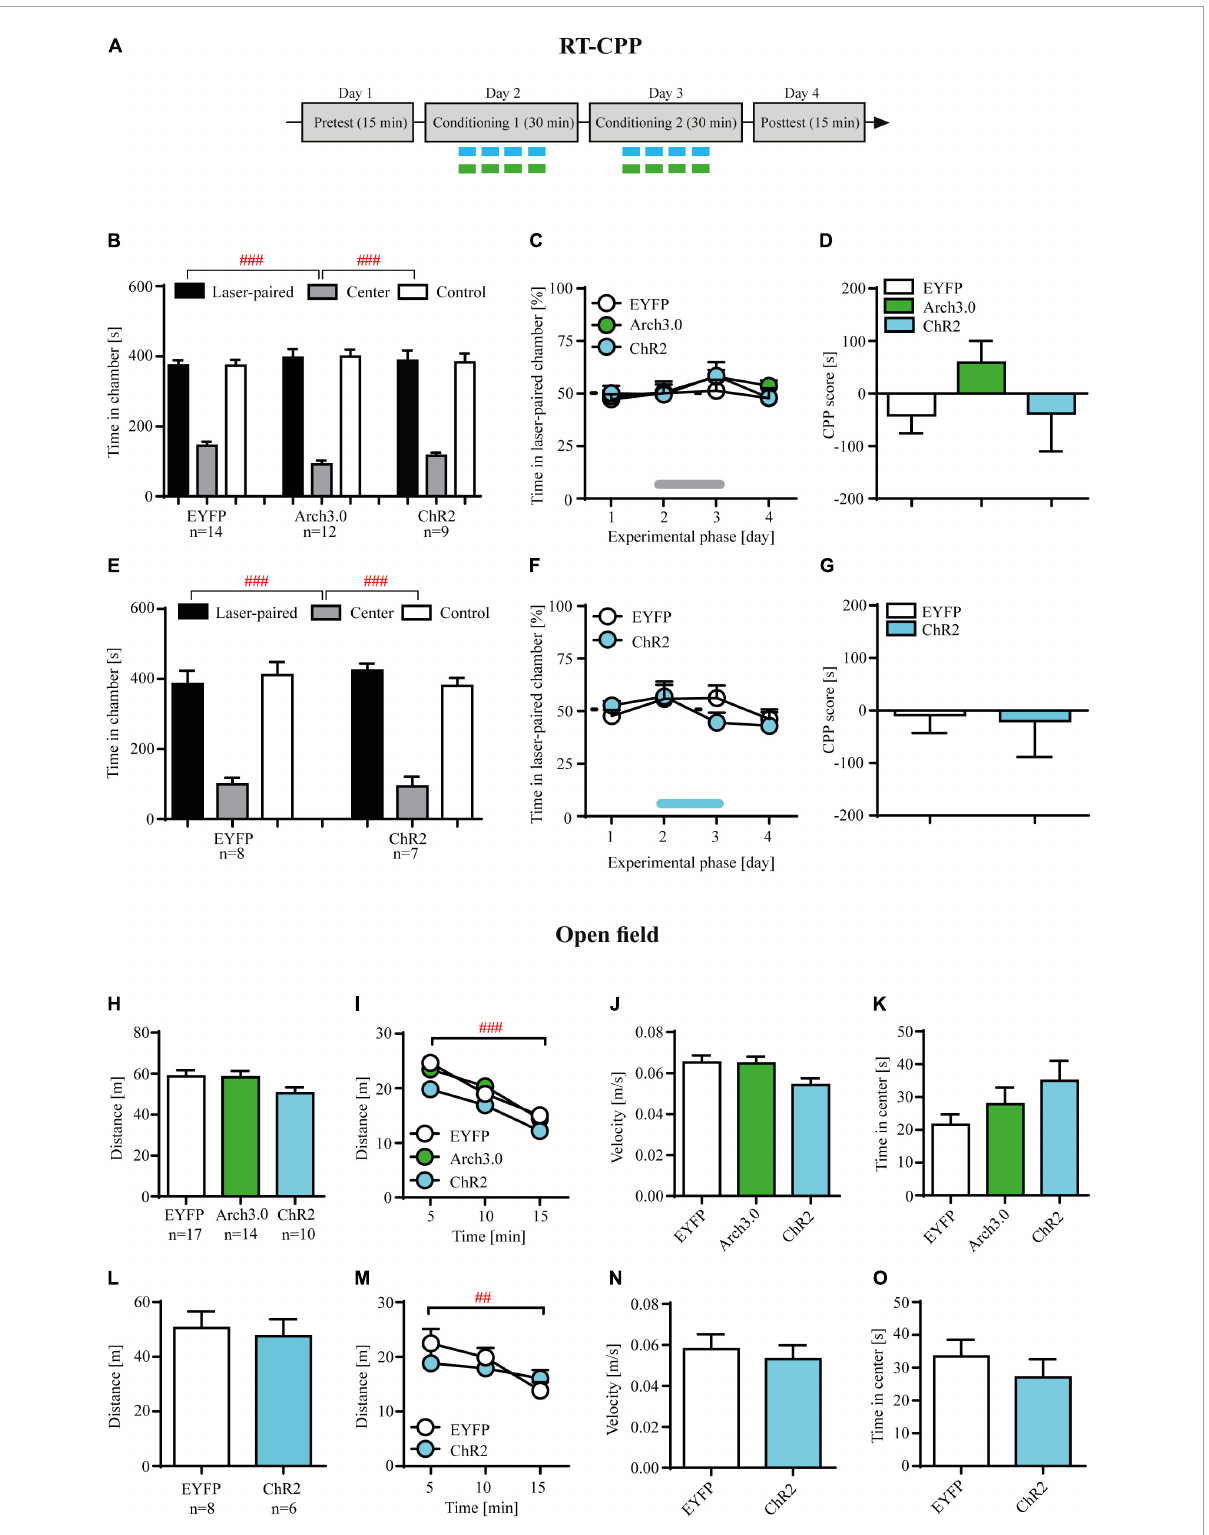
FIGURE4 Brief photo-inhibition or photo-stimulation of locus coeruleus (LC) noradrenergic efferents in ventral tegmental area (VTA) has no effects on hedonic state measured in the real-time place preference and has no effects on locomotor activity or anxiety-like behaviors. (A)